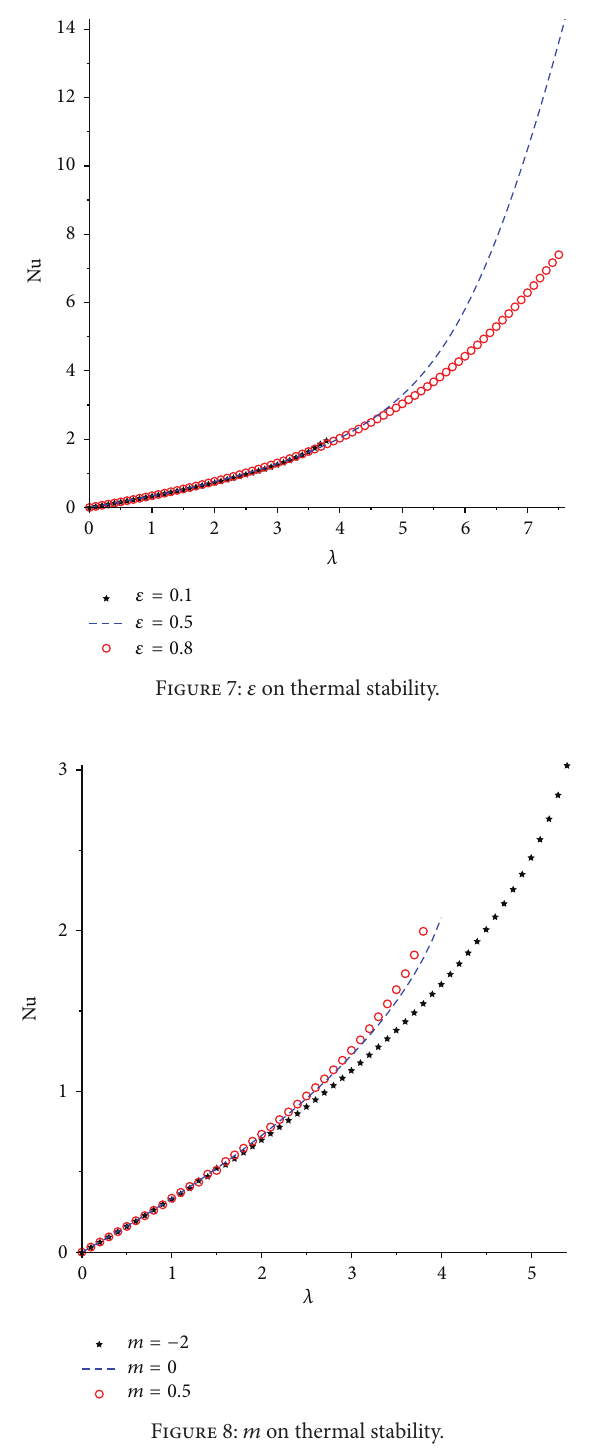
Figure 8: 𝑚 on thermal stability.